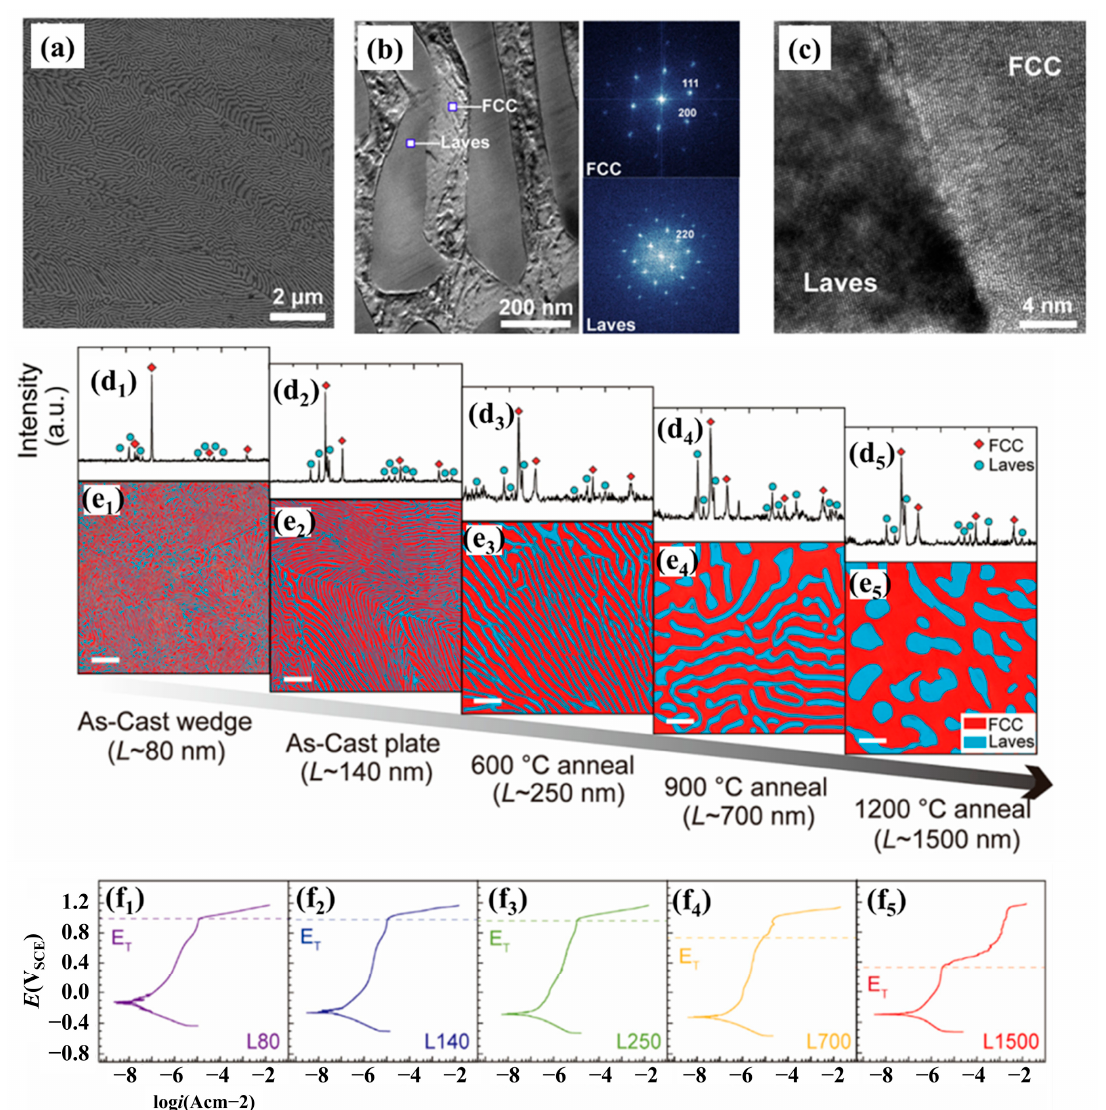
Figure 12. ( a ) the SEM morphology of the FeCrNiCoNb 0.5 EHEA; ( b ) the low magnification TEM morphology of FCC and Laves phases, and the corresponding FFT images in the inset; ( c ) the HRTEM image of the boundary of the phases; ( d 1 – d 5 ) XRD results and ( e 1 – e 5 ) the SEM images of the lamellar structure for the samples with different sizes of lamellar (note that scale bars are equal to 2 µ m in ( e 1 – e 5 )). ( f 1 – f 5 ) potentiodynamic polarization plots of samples with different sizes of lamellar [75,81].